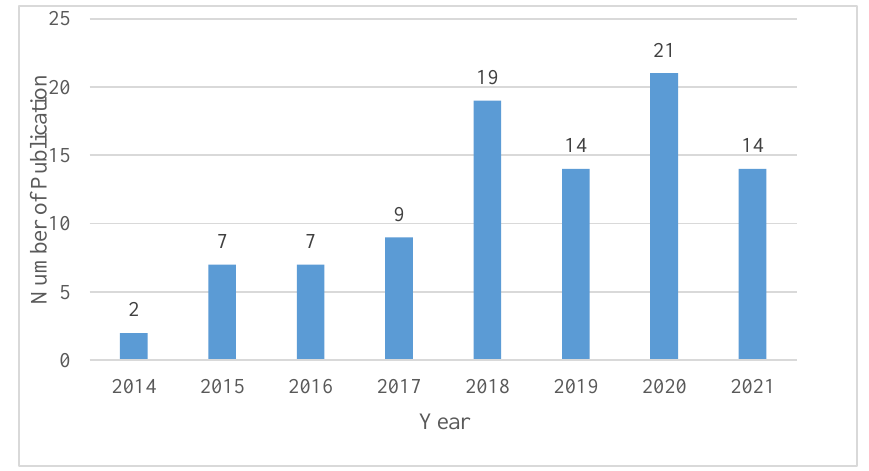
Fig. 3. Number of articles published between 2014 and